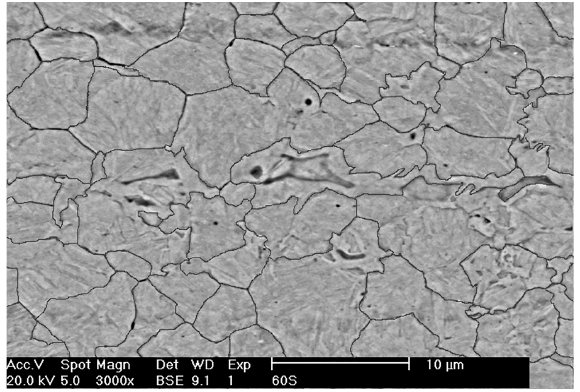
Figure 3. SEM micrograph showing the austenite grain size determined at the intercritical temperature of 800 ◦ C revealing an average size of 4.5 µ m. Sample etched by picric acid